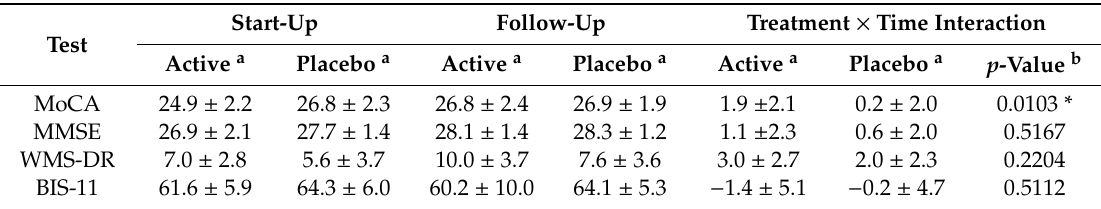
Table 4. Two-way analysis of treatment × time interaction in psychometric tests of active and placebo groups for female subjects.